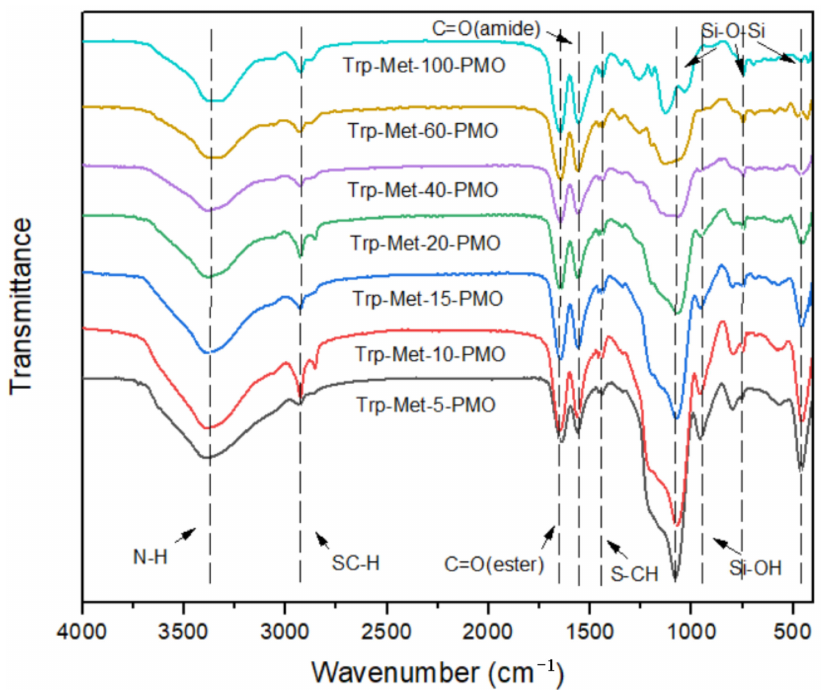
Figure 1. FTIR of mesoporous organosilica Trp-Met-x-PMO (x = 5, 10, 15, 20, 40, 60, 100). The wide-angle X-ray diffraction (XRD) patterns of mesoporous organosilica Trp- Met-x-PMO are shown in Figure 2. All the materials exhibited a high intensity peak from the (100) plane in the range of 2 θ from 1 ◦ to 7 ◦ . Moreover, the intensity of the diffraction peak varied with the changing amounts of dipeptide Trp-Met in the skeleton of the mesoporous organosilica material. Among these materials, only the sample Trp- Met-5-PMO with low amounts of Trp-Met showed three diffraction peaks corresponding to a strong intensity peak of (100) and two weak intensity peaks of (110), (200), which indicated a relatively broad diffraction peak. The result indicated that the material Trp-Met- 5-PMO remained a mesoporous material with well-ordered 2D hexagonal ( P6mm )